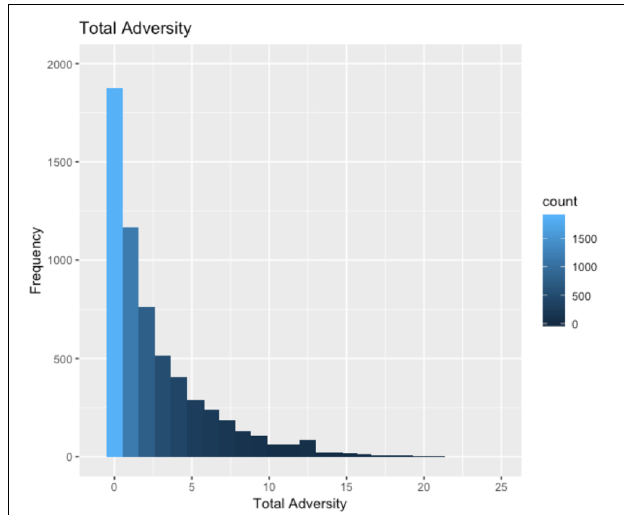
FIGURE 2 | Histogram of total adversity scores in this sample.